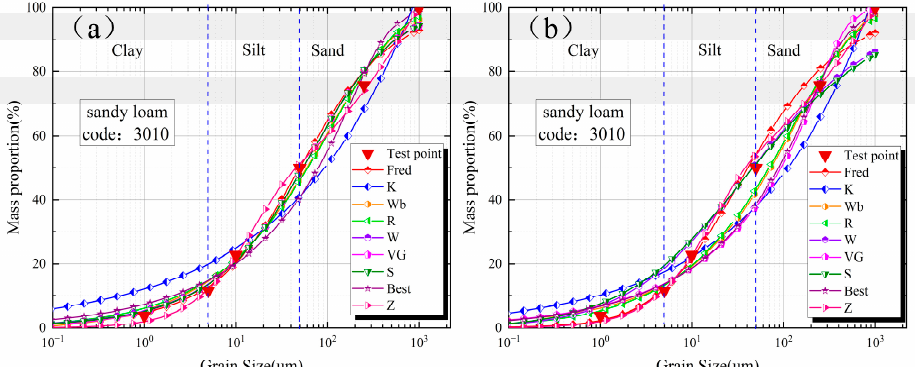
Figure 2. Comparison of the effect of sample point fitting and non-sample point prediction: ( a ) the graph of each model fitted using these six sample points, ( b ) the graph of each model fitted using the five sample points except that with a particle size of 50 μm .